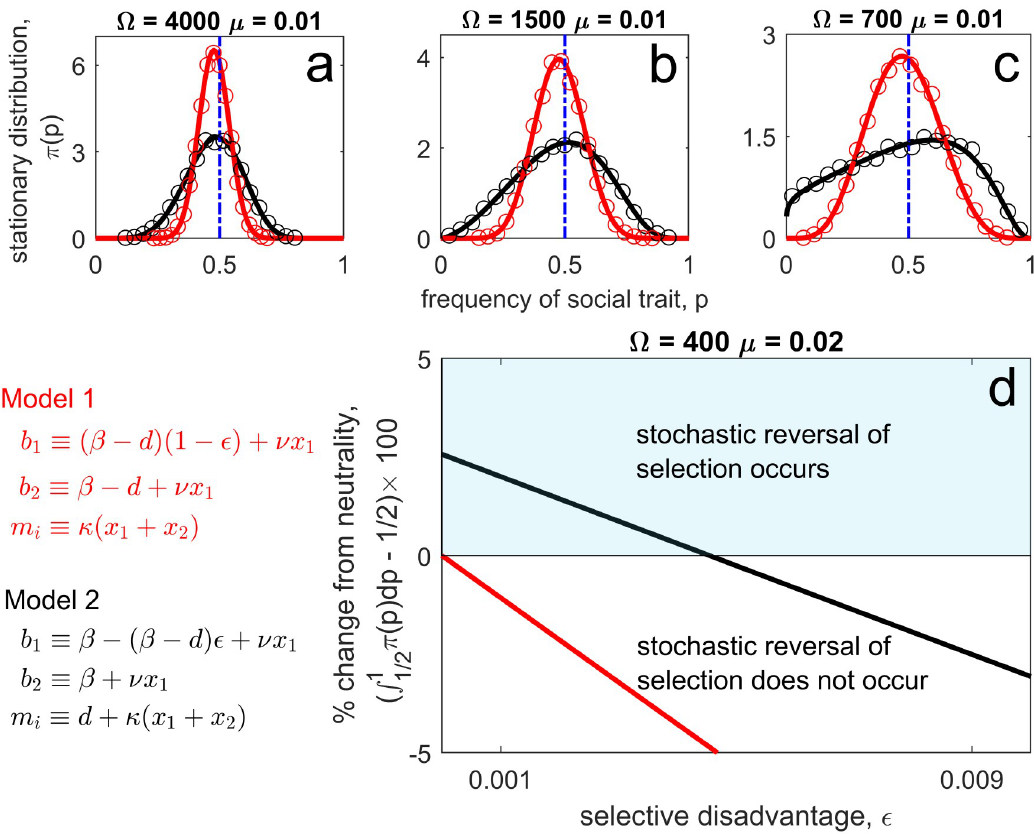
Fig 4. Can stochasticity reverse selection? Here we compare two models of altruism having the same per-capita growth rate, but differing in variance in per-capita growth (Model 1-red, Model 2-black). As a consequence, this can lead to a stochastic reversal of selection for model 2 but not model 1. Subplots a - c : predicted stationary distribution for both models from Eq 1 (curve) compared to 2 × 10 4 simulations of the full stochastic process (circles) for decreasing habitat size, O (i.e., increasing levels of demographic stochasticity). The distribution is always skewed towards the non-altruist in model 1. For model 2 the distribution changes from being skewed towards the non-altruist to being skewed towards the altruist as demographic stochastic increases (i.e., a selective reversal occurs). Subplot d : magnitude of the selective reversal plotted against the cost of altruism. Parameters used were { β , d , κ , ν } = {3, 2.4, 1.2, 1}, with � = 0.003 for subplots a - c .